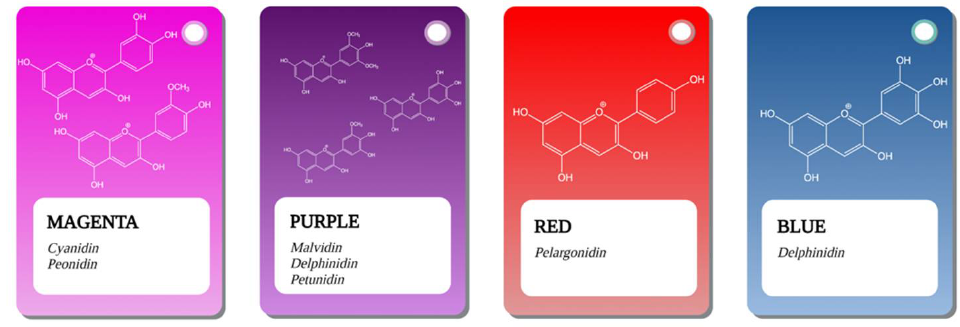
Figure 1. The structure and color of the most common anthocyanins present in nature.